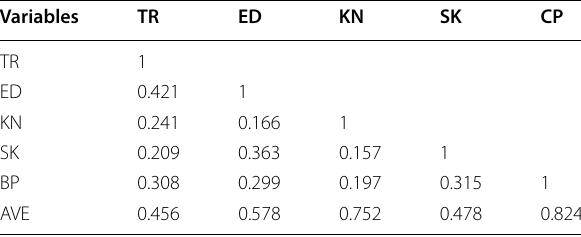
Table 3 Divergent validity analysis